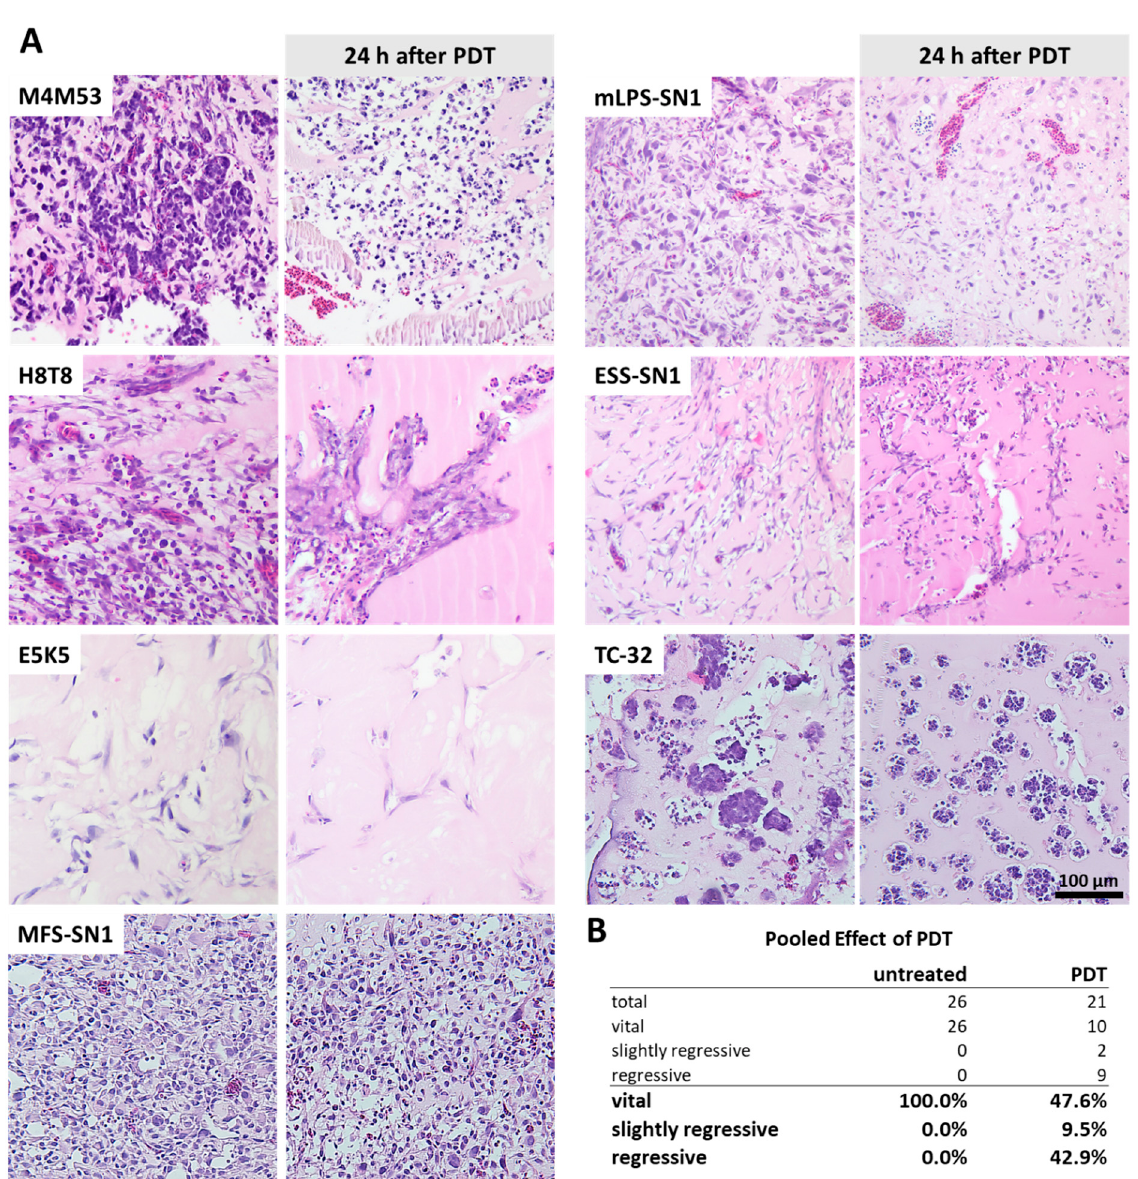
Figure 3. Histopathologic changes upon PDT treatment. ( A ) Histopathology of untreated and PDT-treated CDX tumors of different sarcoma subtypes. Tumors were harvested 24 h after PDT treatment. Ewing sarcoma: M4M53, H8T8, TC-32; myxoid liposarcoma: mLPS-SN1; endometrial stromal sarcoma: ESS-SN1; osteosarcoma: E5K5; myxofibrosarcoma: MFS-SN1. ( B ) Pooled effect of PDT on tumor regression. Details on composition (number of untreated/number of PDT treated): M4M53 (1/3); H8T8 (1/2); E5K5 (6/2); ESS-SN1 (4/3); mLPS-SN1 (3/4); MFS-SN1 (5/3); TC-32 (6/4).